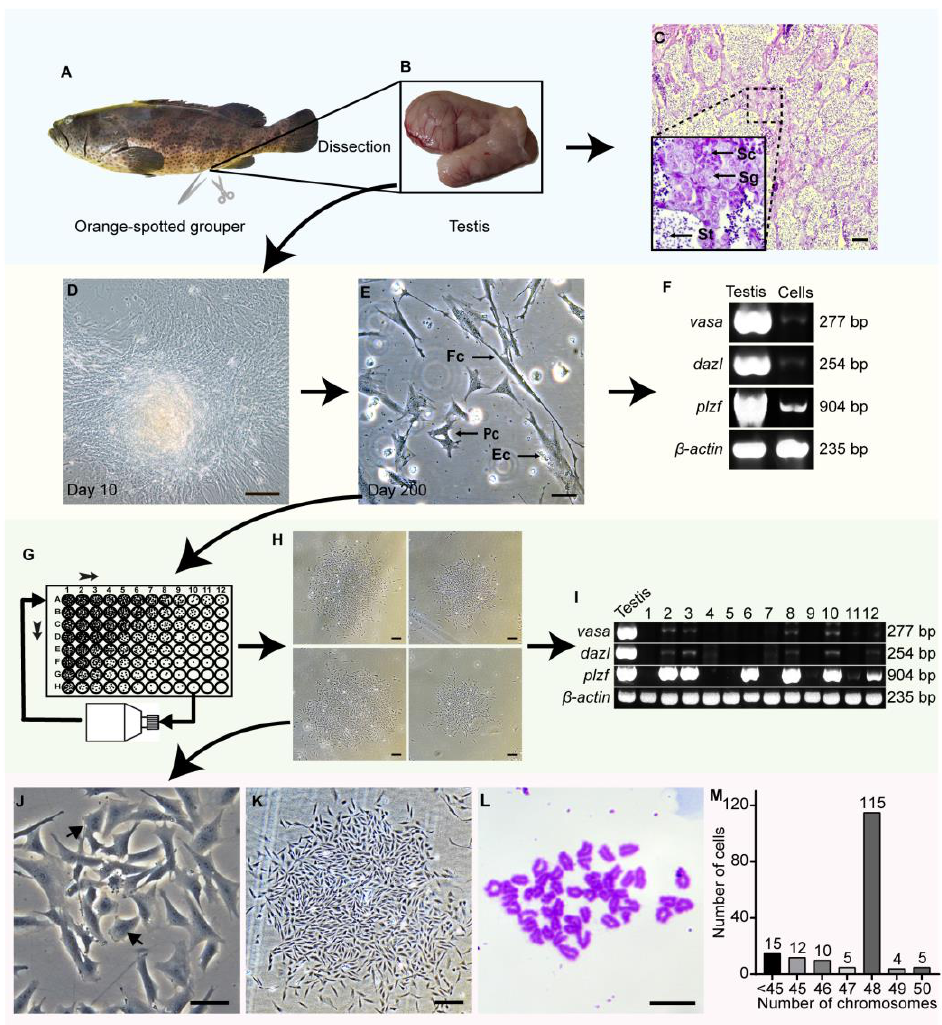
Figure 1. Establishment of an SSC line in orange-spotted grouper. ( A ) The fish image of orange- spotted grouper. ( B ) The testis was dissected from male orange-spotted grouper. ( C ) Histological structure of testis and the magnification of the framed area showing spermatogenic cells at different stages during spermatogenesis. ( D ) The primary cell culture on the 10th day. ( E ) Morphologies of testicular cells after 200 days of culture. ( F ) Expression of germ cell genes vasa , dazl , and plzf in testis and the testicular cells cultured over 200 days. The β -actin was used as an internal control. ( G ) Dia- gram of isolating single-cell colonies from the cultured testicular cells. The short arrow represents the order of serially diluting cell suspension in a 96-well plate. The dot in the wells represents a single colony. The single colony in the wells is expanded in a culture bottle for the next round of purification. ( H ) Colonies of stable testicular cell lines after four rounds of single colony selection and expansion. ( I ) Expression analysis of vasa , dazl, and plzf in testis and 12 stable testicular cell lines at passage 70. ( J ) Morphology of a putative SSC line named GPT with expressions of vasa , dazl , and plzf , and its nucleus with apparent nucleoli (Arrows). ( K ) A single colony of GPT cells at passage 99 and day 516. ( L ) Diploid karyotype of 48 chromosomes of GPT cells. ( M ) Chromosome number distributions in 166 metaphases of GPT cells. Sg, Spermatogonia; Sc, Spermatocyte; St, Spermatid; Fc, Fibroblast-like cell; Ec, Epithelial-like cell; Pc, polygonal-like cell. Scale Bars: 200 µm in ( C , H , K ); 100 µm in ( D ); 50 µm in ( E , J ); 5 µm in ( M ).